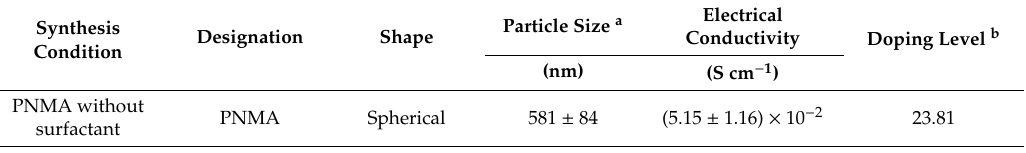
Table 1. σ values, shape, and particle size of the synthesized PNMA of various